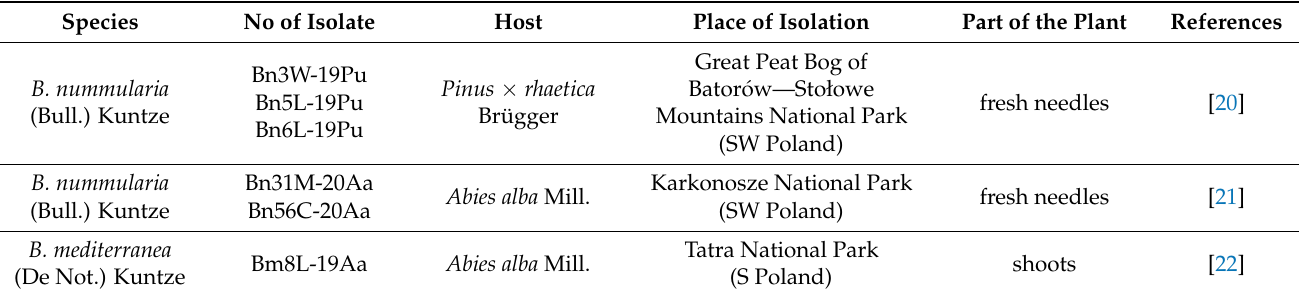
Table 1. Characteristics of isolates of Biscogniauxia nummularia and Biscogniauxia mediterranea , isolated from Poland, included in the